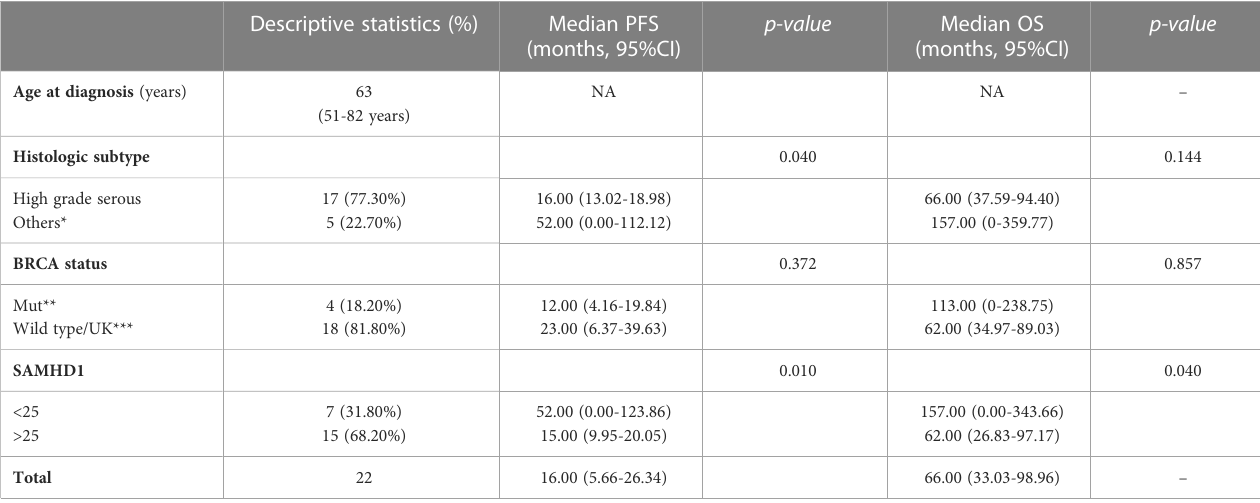
TABLE 1 Baseline characteristics of the clinical sample and survival